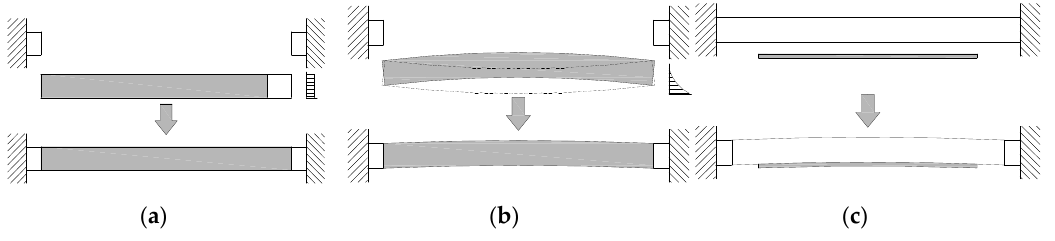
Figure 2. Types of thermal prestressing methods. ( a ) Uniform temperature; ( b ) Temperature gradient; ( c ) Thermally prestressed cover plate.